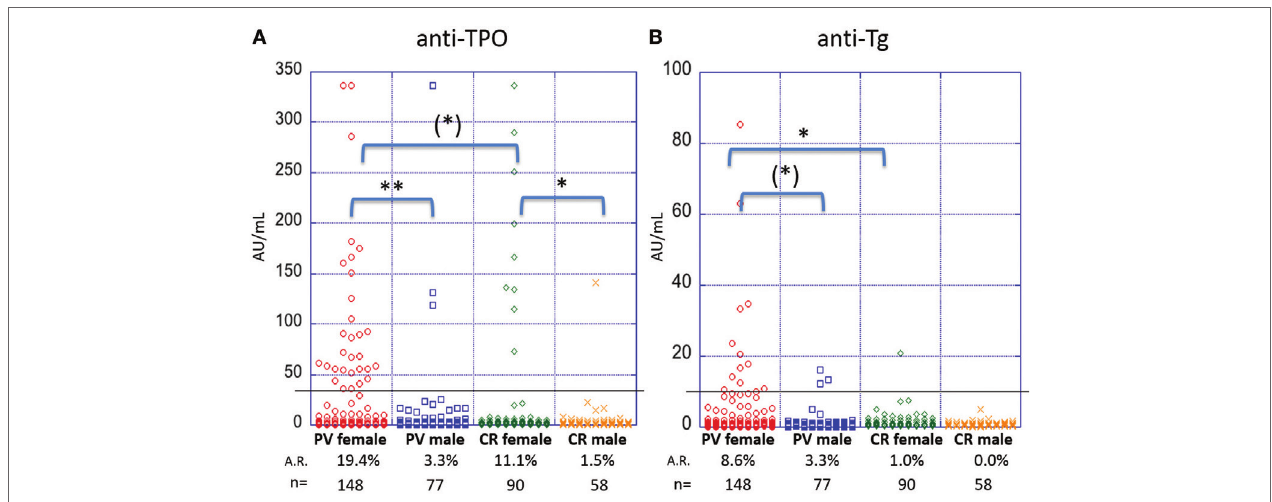
FigUre 3 | Activity rates of anti-thyroid peroxidase (anti-TPO) and anti-thyroglobulin (anti-Tg) based on sex. Individual dots represent anti-TPO and anti-Tg levels (in AU/ml) in pemphigus vulgaris (PV) patients and controls, both female and male for (a) anti-TPO and (b) anti-Tg antibodies [(*) p < 0.1, * p < 0.05, and ** p < 0.01]. Abbreviation: A.R., activity rate. Anti-TPO and anti-Tg antibody rates were modeled as a function of sex using a generalized estimating equations logistic regression